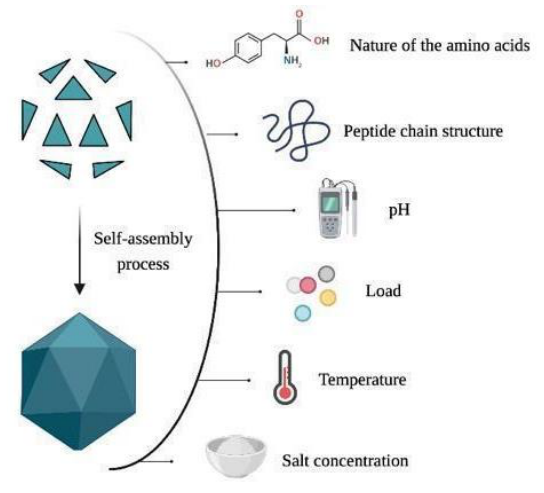
Figure 5. Factors influencing the design and production of VLPs.